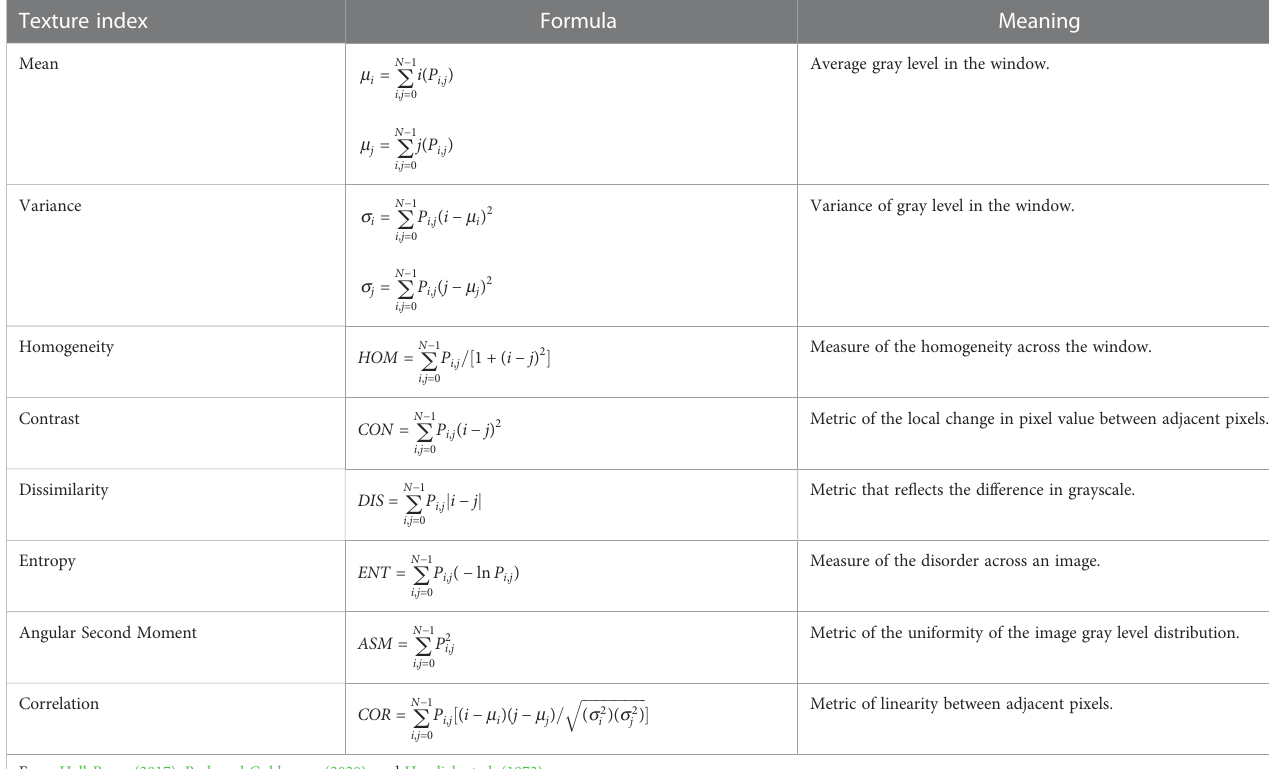
Average gray level in the window.